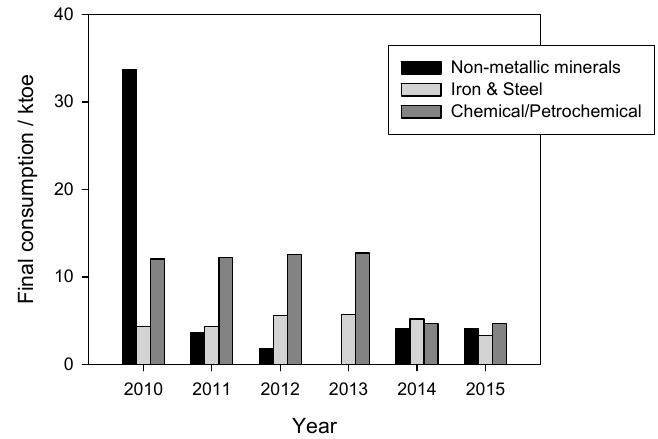
Figure 6. Coal consumption by the industry sub-sectors from 2010 to 2015 [27].